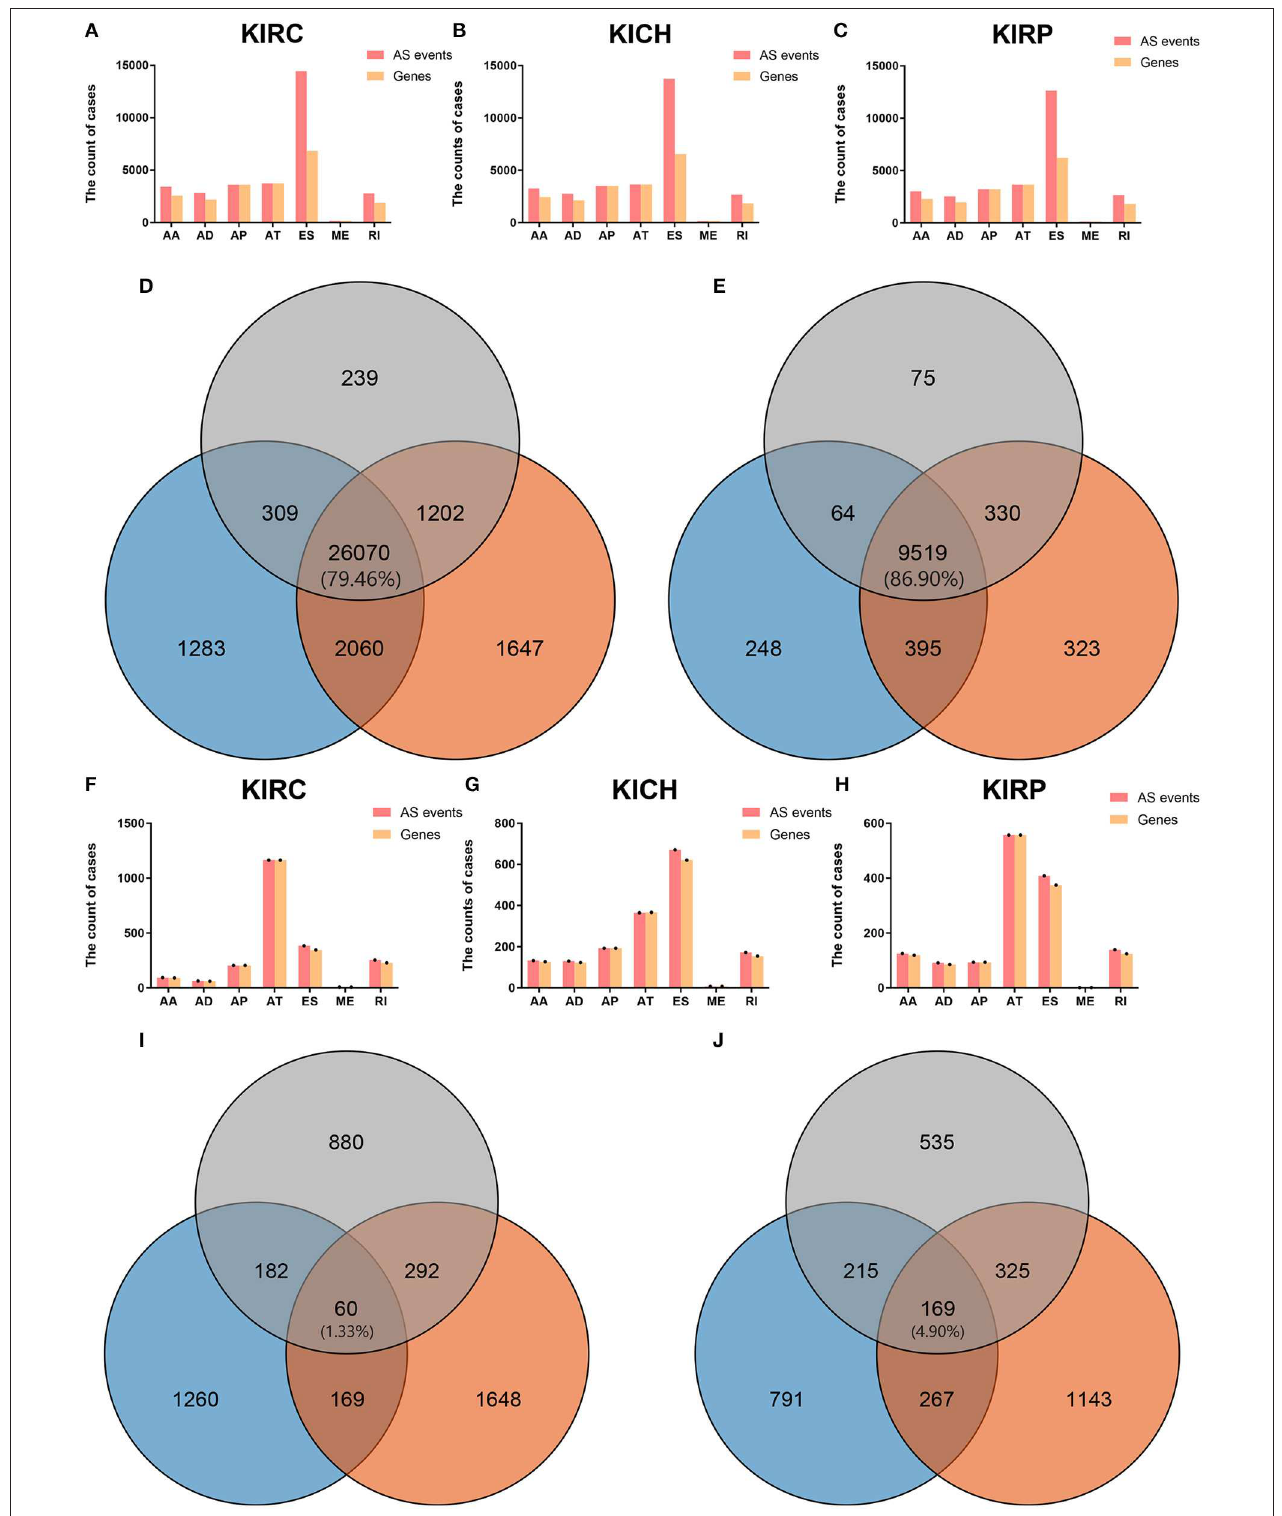
FIGURE 1 | The AS events, SREs and relevant genes in RCC. (A–C) The height of the pink strip represented the number of AS events. The height of the orange band represented the number of relevant genes. (D) The orange, blue, and gray areas represent the events in KIRC, KICH, and KIRP, respectively. The percentage value